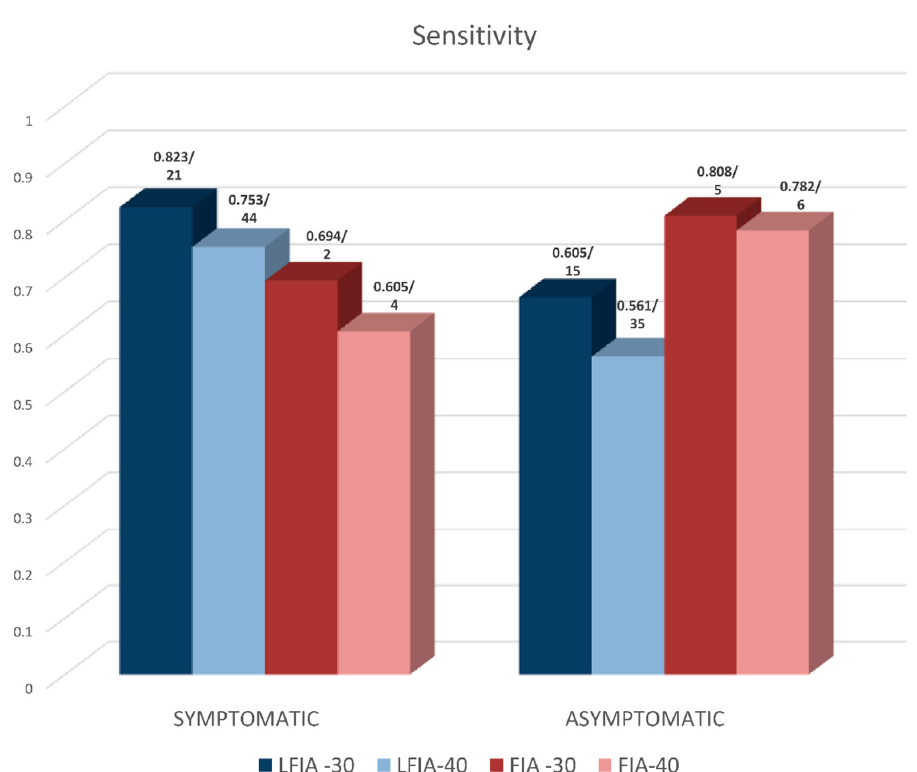
Figure 3. Performance of LFIA and FIA methods (N antigen-based) in terms of sensitivity on NSP samples in symptomatic vs. asymptomatic persons. Included assays in the meta-analysis are per- formed with positive samples for either Ct < 30 or Ct < 40. Numbers above the bars depict sensitivity values/number of studies included in each meta-analysis. Table 4. Results of the meta-analysis for the different types of assays for symptomatic and asymp- tomatic patients. Listed information includes the pooled sensitivity and specificity along with the 95% confidence intervals. (NSP: pharyngeal, nasopharyngeal, nasal specimens, TS: throat, saliva, N: nucleocapsid protein, S: spike protein, NS: nucleocapsid and Spike proteins).